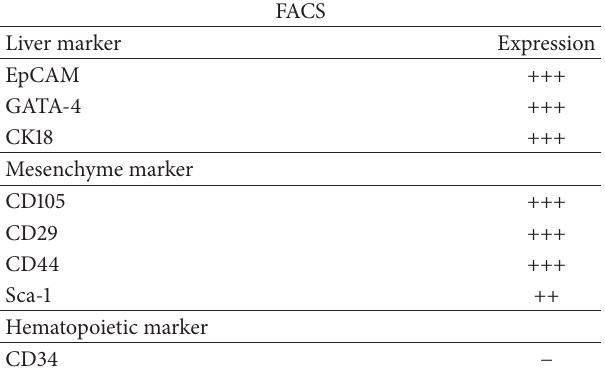
Table 2: Summary of the phenotype and genotype of isolated